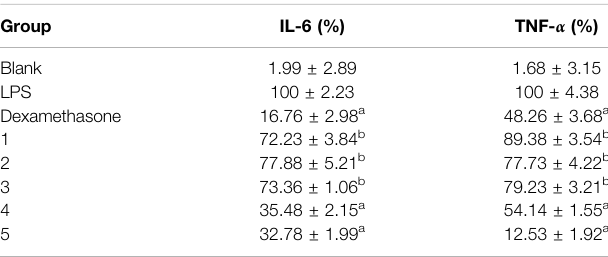
TABLE 3 | Anti-in fl ammatory activitiesofcompounds 1 – 5 in LPS-stimulated RAW 264.7 cells.